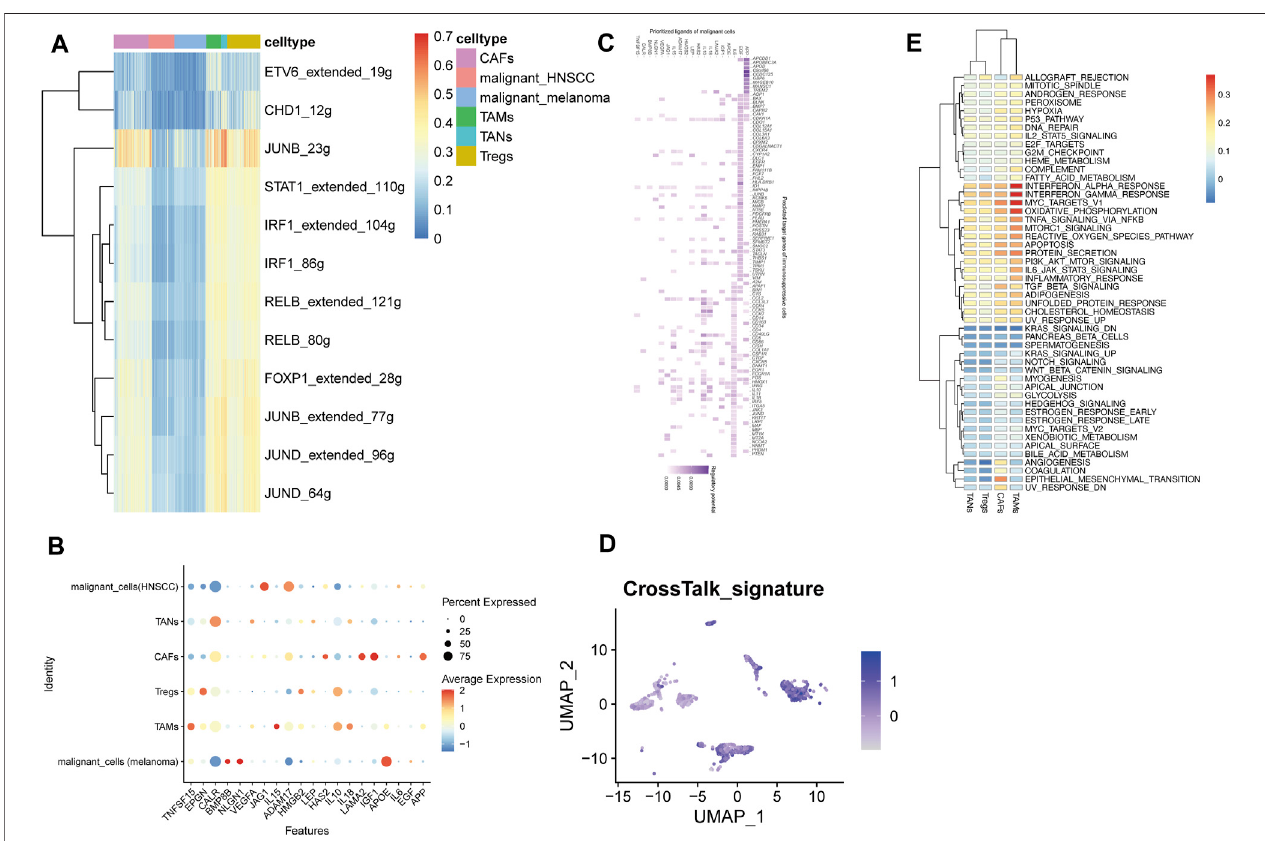
FIGURE 2 | GRNs analysis and communication network of immunosuppressive cells and malignant cells. (A) Regulon activity across immunosuppressive and malignant cells. (B) The top 20 ligands among immunosuppressive and malignant cells. (C) The Ligand-target gene matrix denoted the top targeted genes of immunosuppressive cells by the top 20 ligands of malignant cells. (D) Activity score of the constructed communication signature. (E) Differences in pathway activity in four immunosuppressive cell